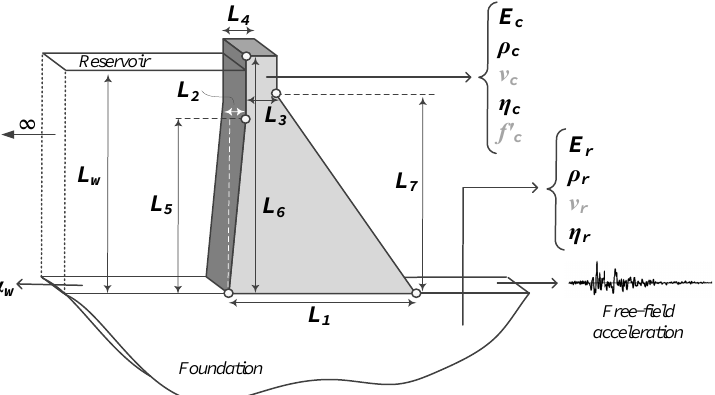
Figure 2. Generic shape of a gravity dam including design variables, material parameters, water, and seismic